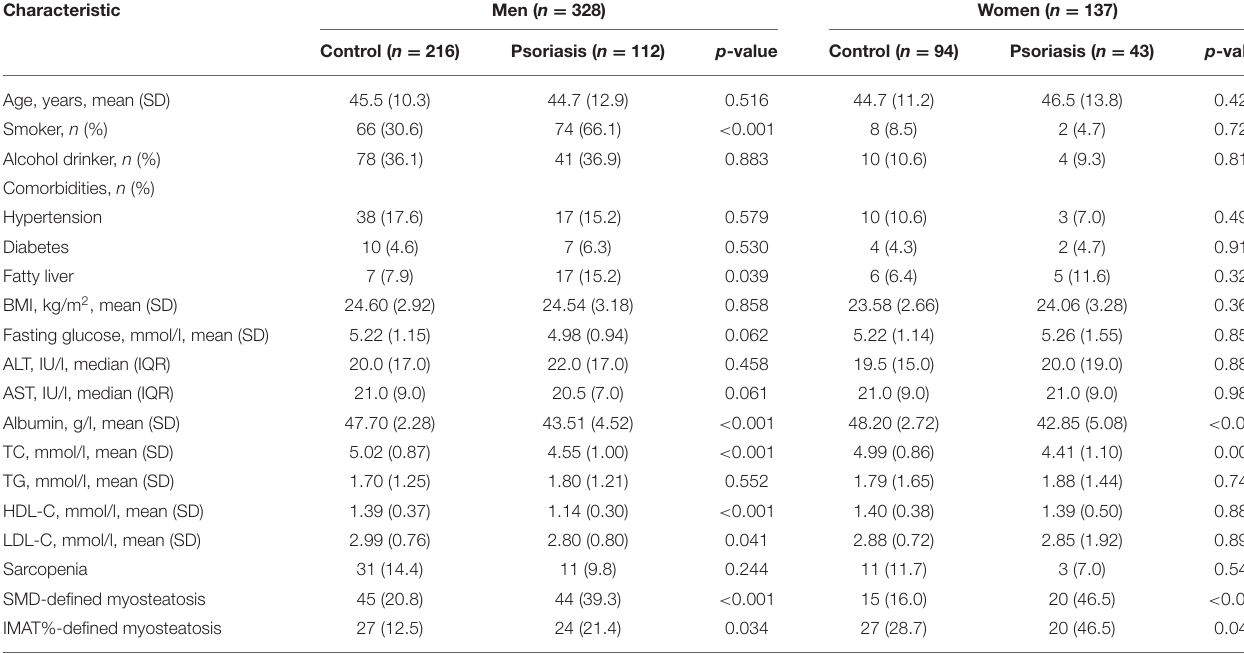
TABLE 2 | Characteristics of the study population after propensity score matching.